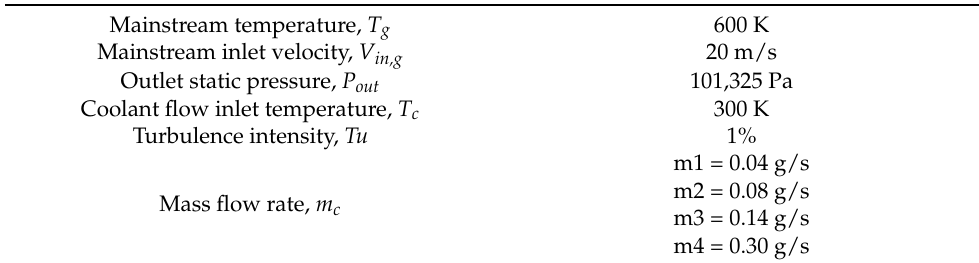
Table 1. Boundary conditions of computational